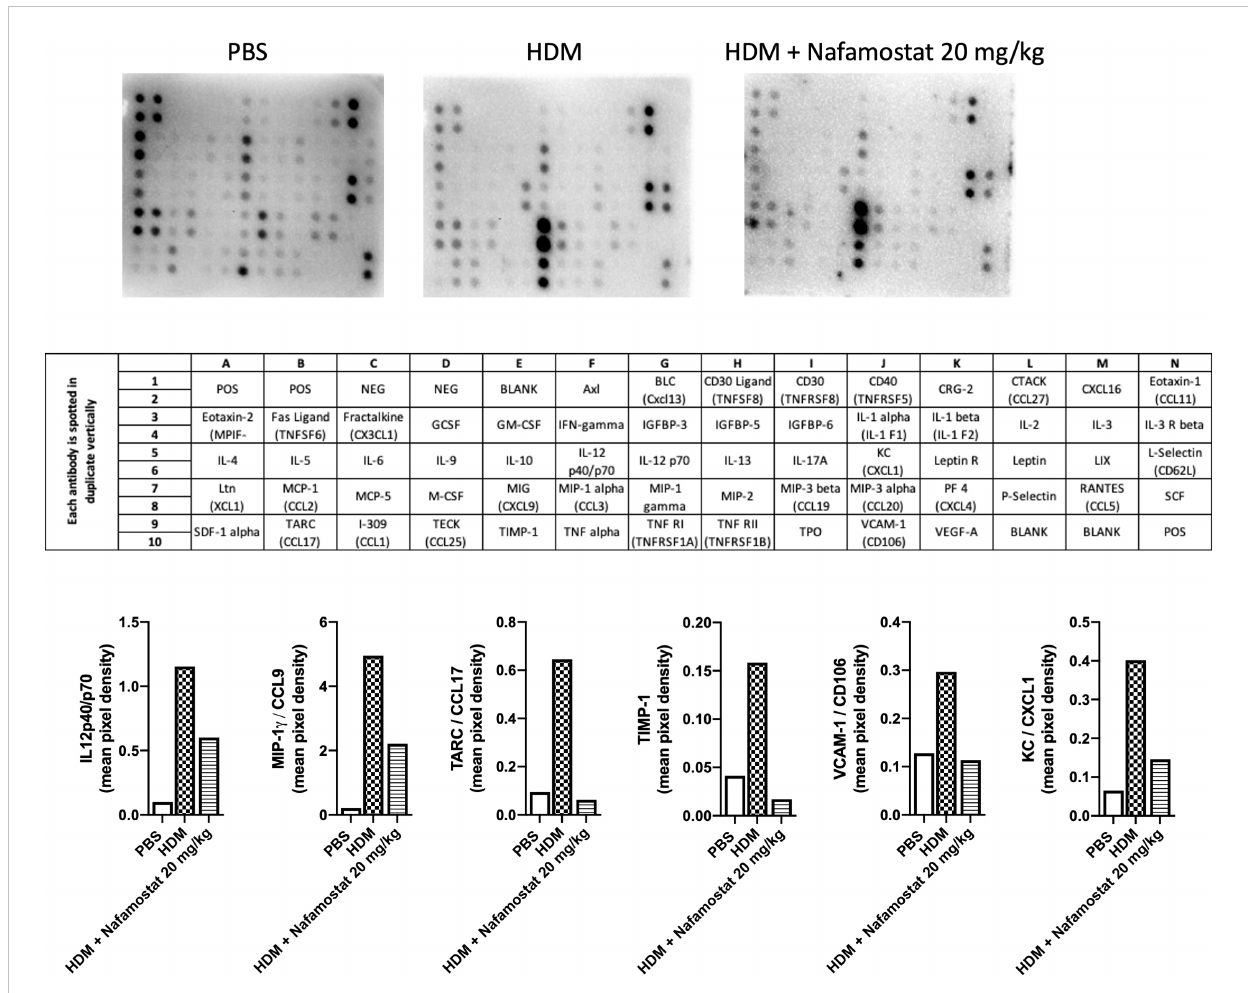
FIGURE 3 Effects of nafamostat on the release of cytokines into the BAL fl uid of mice subjected to HDM-induced experimental asthma. Mice received either PBS or HDM extract twice a week for 6 weeks. Mice were treated with vehicle or with nafamostat (20 mg/kg) 30 min prior to each HDM instillation. Control mice were treated with PBS only. BAL fl uid was collected, centrifuged and BAL fl uid supernatants were pooled from each group and were then analysed with a RayBio mouse cytokine array. The pixel densities were semi-quanti fi ed using ImageJ protein array analyzer and are represented as mean pixel density. n = 4 mice per group. HDM, house dust